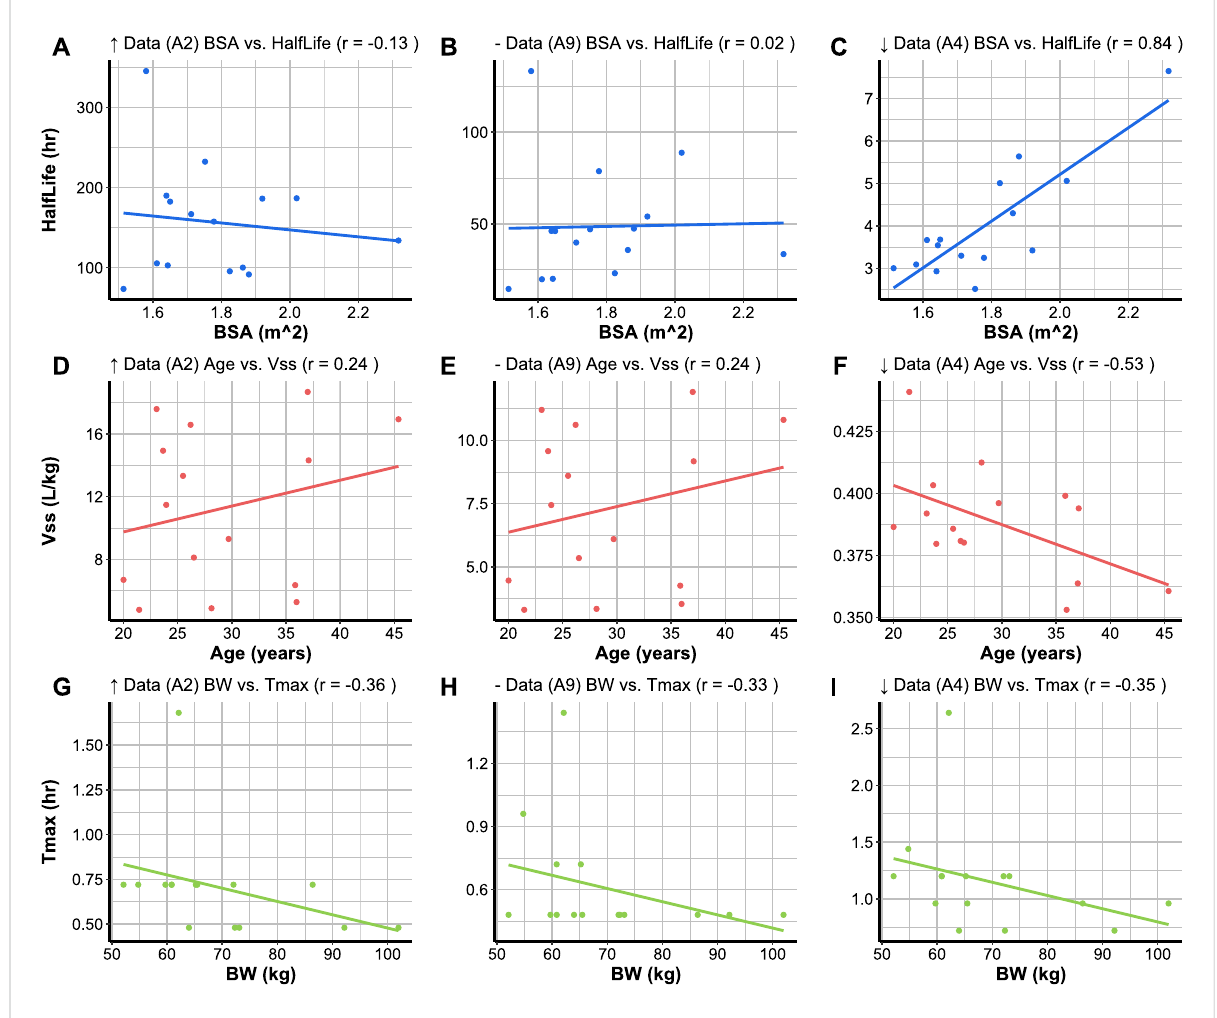
FIGURE 5 User-chosen variables for x and y axesare plottedagainst eachother with the correlation coef fi cient ( r )intheplot headers. (A) , (D) , and (G) display therelationshipsbetweenvariablesforacompound(A2)withhighdataavailability( ↑ Data). (B) , (E) ,and (H) displaytherelationshipsbetweenvariablesfor a compound (A9) with medium data availability ( − Data). (C) , (F) and (I) display the relationships between variables for a compound (A4) with low data availability ( ↓ Data). The plots (A – I) have been created based on 15 subjects randomised with the same seed for each